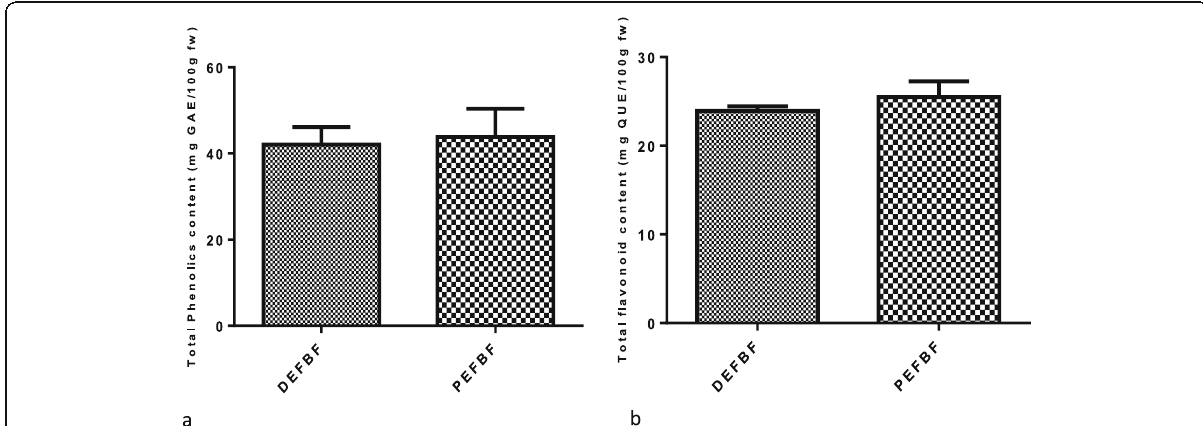
Fig. 1 ( a - b ): In vitro antioxidant capacity of petroleum and diethyl ether fractions of B. ferruginea Benth leaves: ( a ) Total flavonoids content ( b ) Total Phenolics content. PEFBF: Petroleum ether fraction of B. ferruginea; DEFBF: diethyl ether fraction of B.